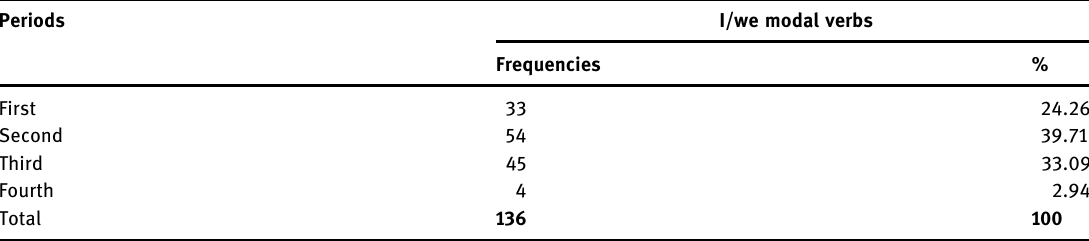
Table 7: Frequencies and percentages of I/we modal verbs in the four time periods Periods